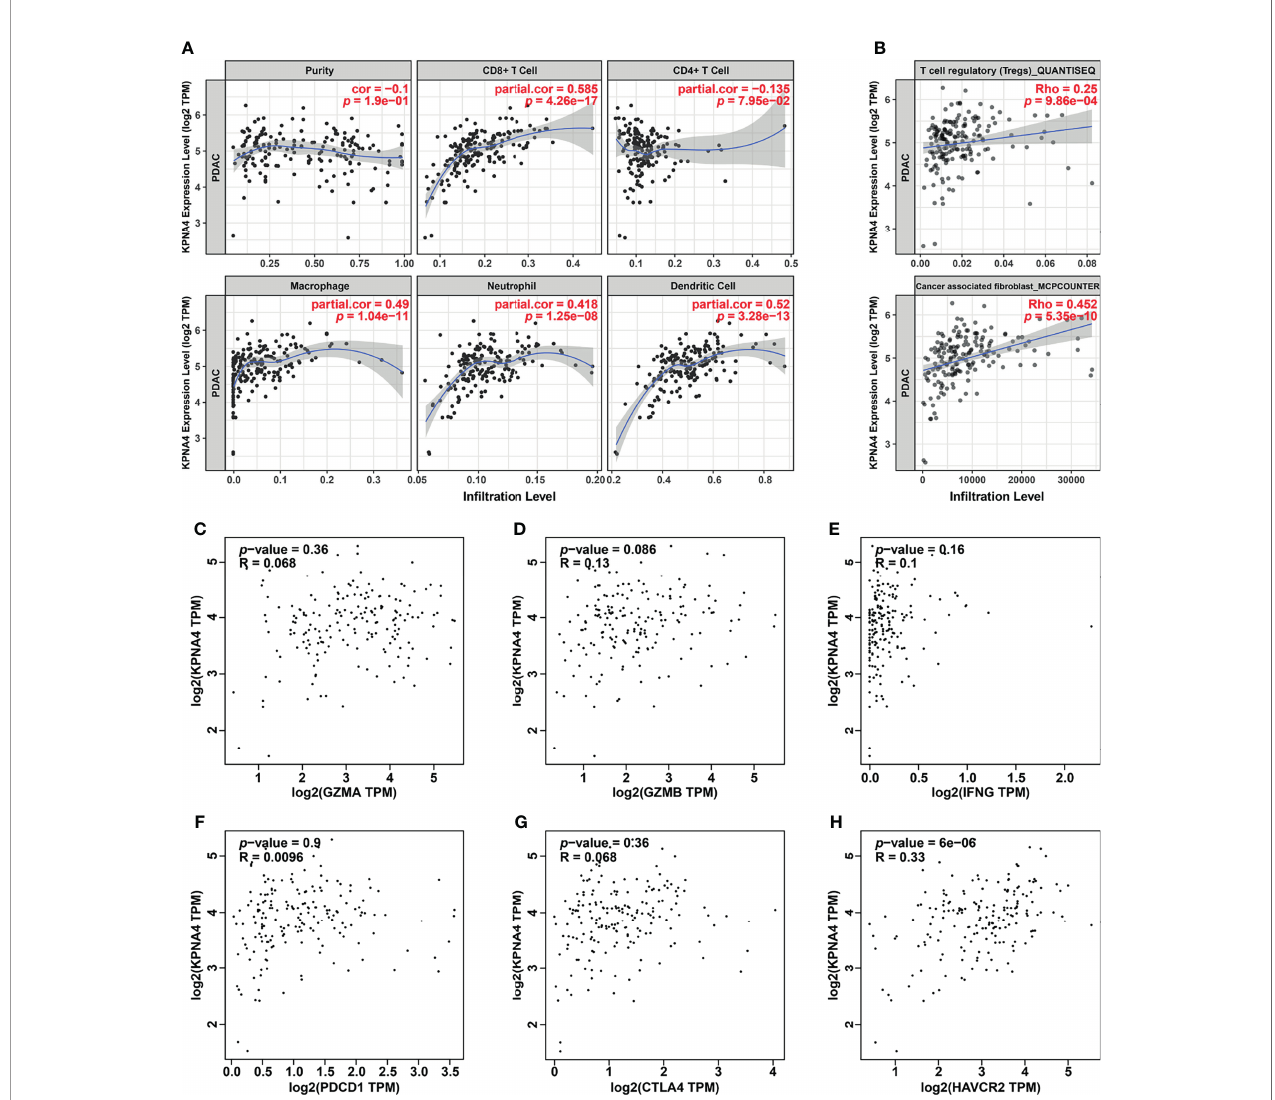
FIGURE 5 | Immune in fi ltration analysis of KPNA4 in PDAC. The correlation between KPNA4 expression and various immune cells in fi ltration in PDAC was analyzed using TIMER (A) as well as TIMER2.0 database (B) . The expression of KPNA4 showed no signi fi cant relationship with cytotoxic CD8 + T cells markers ( GZMA , GZMB and IFNG ) (C-E) . There was no correlation between KPNA4 expression and PDCD1 and CTLA4 (F, G) , while KPNA4 was associated with HAVCR2 , which is another marker of exhausted T cells (H) . p -value < 0.05 was considered to be statistically signi fi